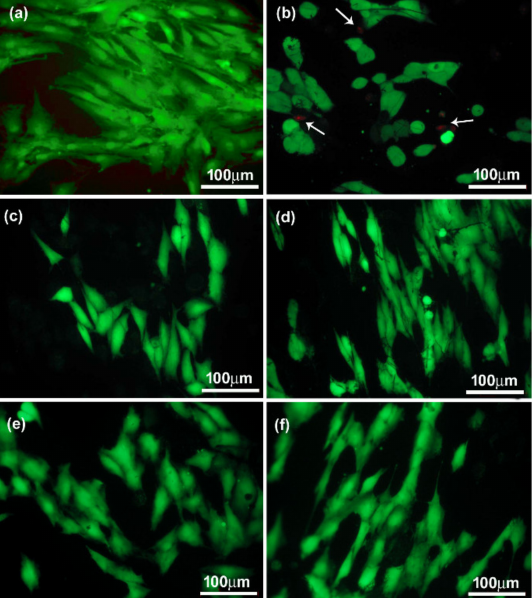
Figure 10. Merged microphotographs of osteoblast-like (MG-63) cells stained with calcein AM/propidium iodide grown on control (PS) ( a ) and CNF before ( b ) and after surface modification: ( c ) CNF_ox, ( d ) CNF_NaH, ( e ) CNF_GO and ( f )